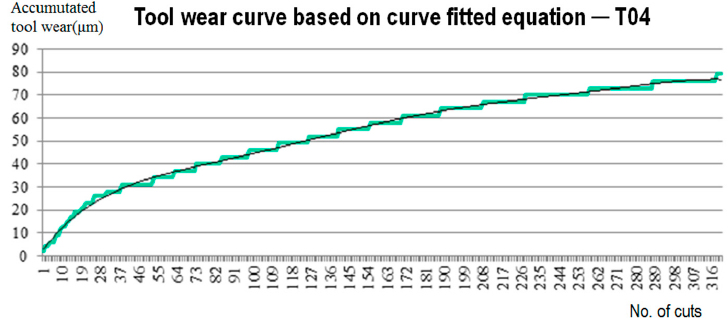
Figure 15. Tool wear curve for T04.